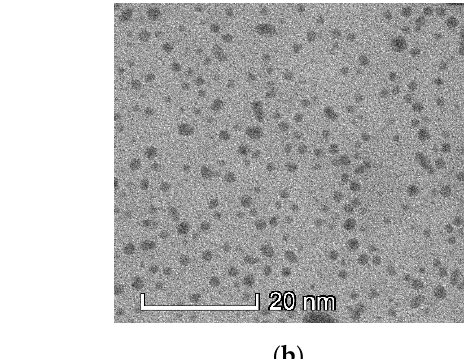
Figure 6. ( a ) Absorption peak of CQDs (black line) and AgNPs (red line) and ( b ) excitation (358 nm) and emission (440 nm) of CQDs.